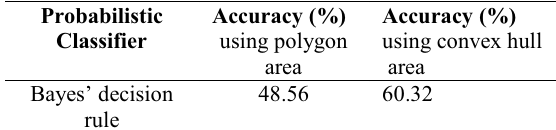
Table 9. Bayes’ rule classifier using polygon and convex hull area